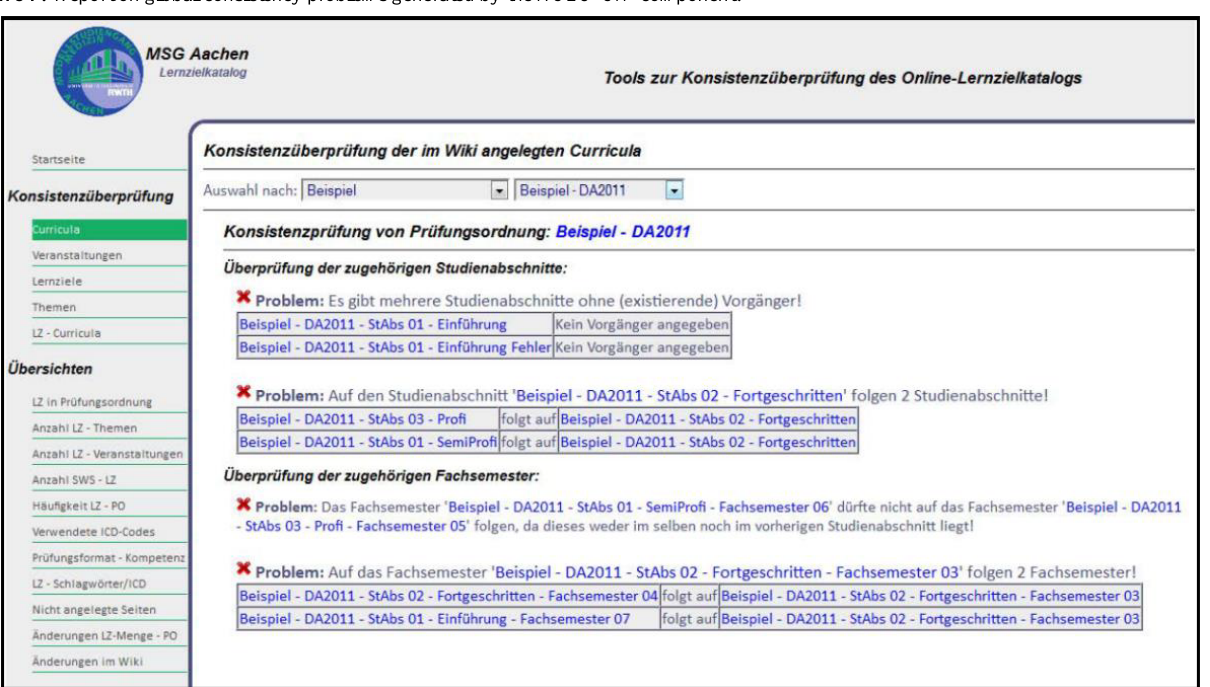
Figure 7. Report on global consistency problems generated by the ACLO-CM